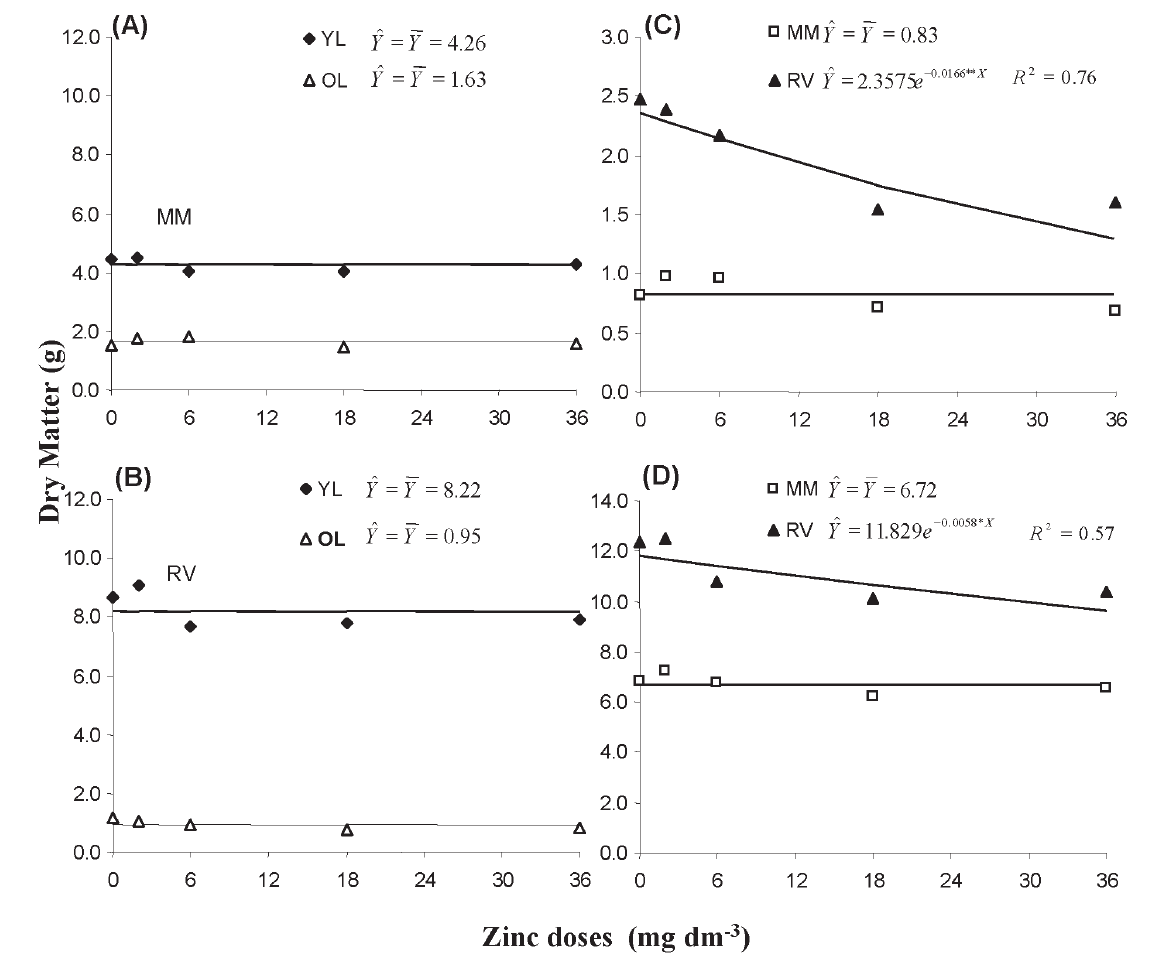
Figure 4 - Dry matter of: (A) young leaves-YL and old leaves-OL of Mimosa-MM; (B) young leaves-YL and old leaves-OL of Regina Verao-RV; (C) roots; and (D) whole plant, in lettuce cultivars Mimosa and Regina Verao, as a result of Zn doses applied to soil (plants were grown for 44 days in the Zn amended